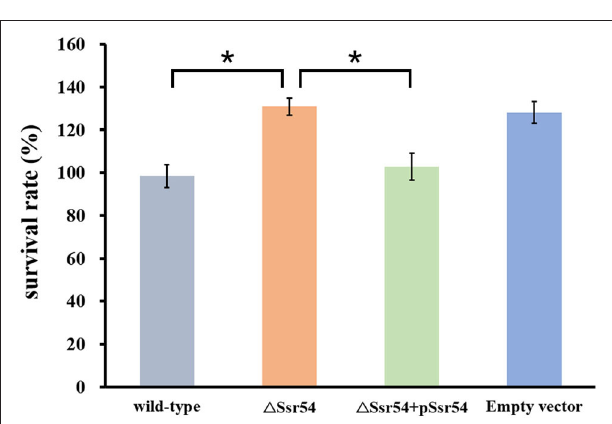
FIGURE 4 | Survival of the sRNA Ssr54 mutant strain ( 1 Ssr54 ) relative to that of the wild-type S. flexneri 301 strain when exposed to high osmotic stress. Wild-type S. flexneri 301, 1 Ssr54 , the complement ( 1 Ssr54 + p Ssr54 ) strain, and mutant strain carrying the pACYC184 empty vector were grown in Luria-Bertani medium (160mM NaCl) up to the exponential phase and then subjected to high osmotic stress (680mM NaCl). Viability was determined by counting bacteria plated in serial dilutions. Bars represent the mean percent survival compared with untreated controls. Statistical analyses were performed using Student’s t -test. Data represent the average of biological triplicates, and errors bars indicate one standard deviation. *Denotes a significant difference with P <